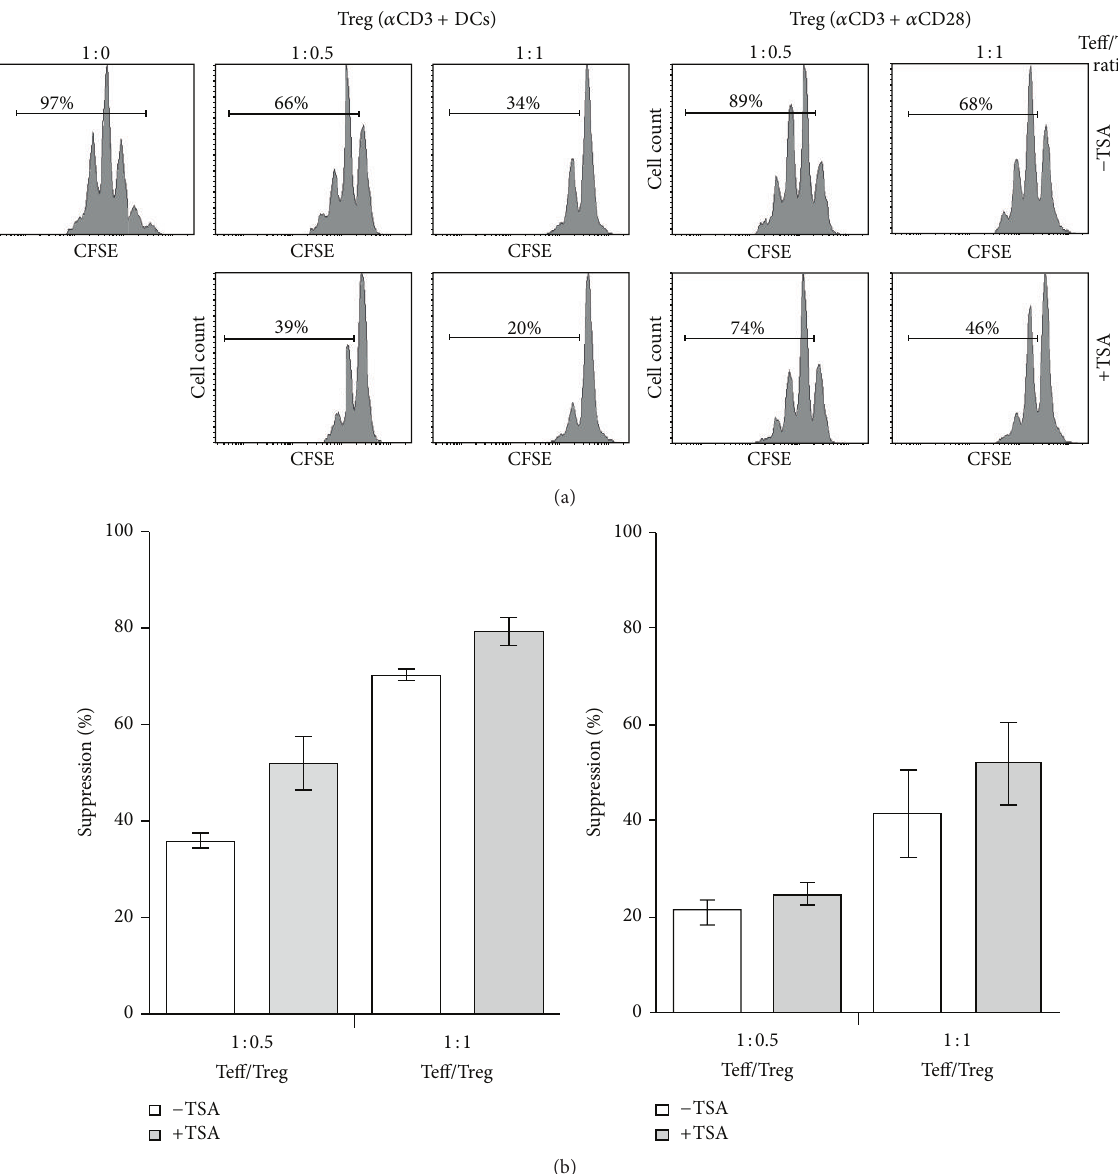
Figure 3: TSA Treg presents higher suppressive capacity. (a) Treg suppression assays of Tregs generated in the presence (left) or absence (right) of dendritic cells, and with (+TSA) or without TSA ( − TSA). Tregs from each group were added to CFSE-labeled naive CD4 + T cells cocultivated with dendritic cells plus anti-CD3 antibody. The percentage of proliferating T cells is shown in each plot. Data are representative of three independent experiments. (b) Quantitation of the percentage of suppression of Tregs generated with or without TSA in the presence of anti-CD3 and dendritic cells (left) or plate-bound anti-CD3 and soluble anti-CD28